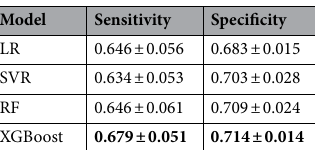
Table 5. Sensitivity and specificity of the four models. Significant values are in